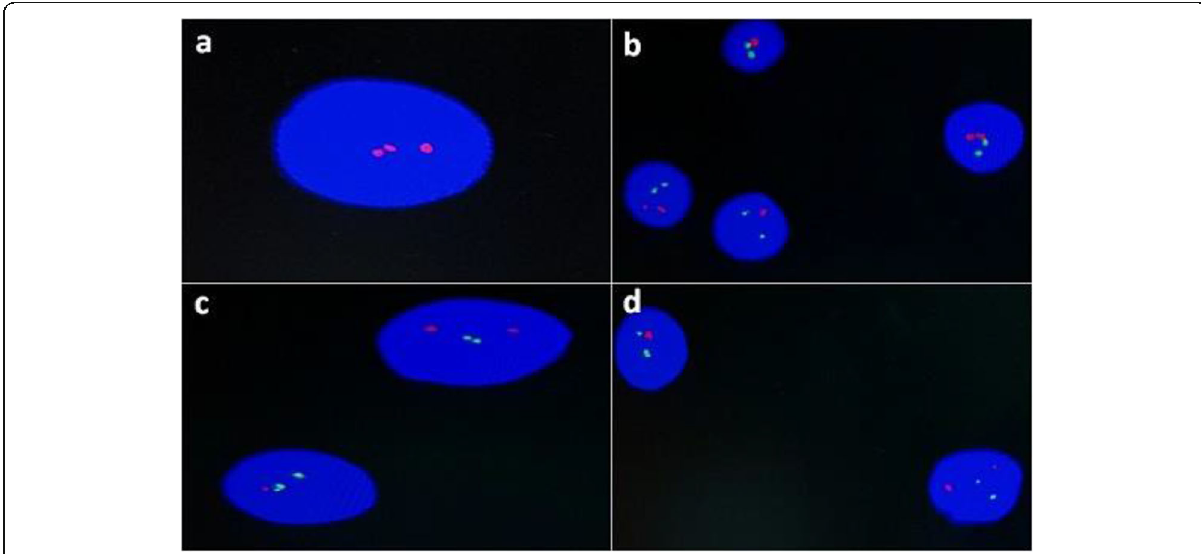
Fig. 1 FISH analysis showing a trisomy 12 denoted by the presence of three red signals, b mosaic positive 11q23 del denoted by the presence of one red signal and two control green signals for centromere 11, c mosaic positive 13q14 del denoted by the presence of one red signal and two control green signals for the 13q34 region, and d mosaic positive 17p13 del denoted by the presence of one red signal and two control green signals for centromere